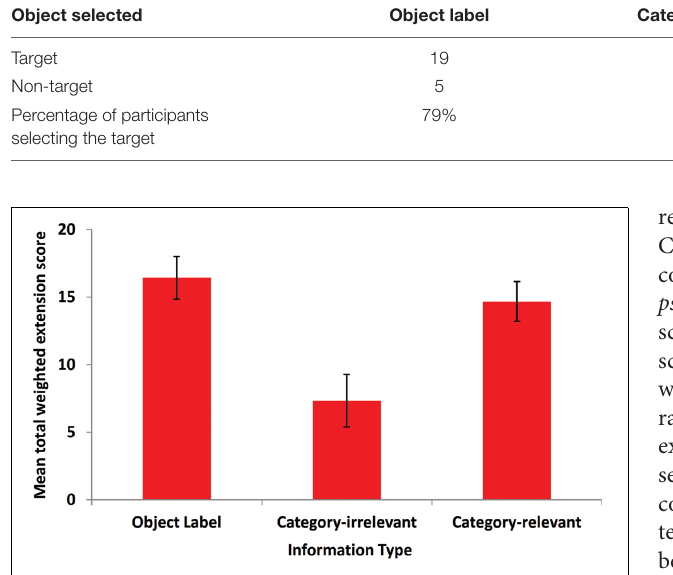
FIGURE 3 | Mean extension test scores by Condition (error bars are ± 1 SE).